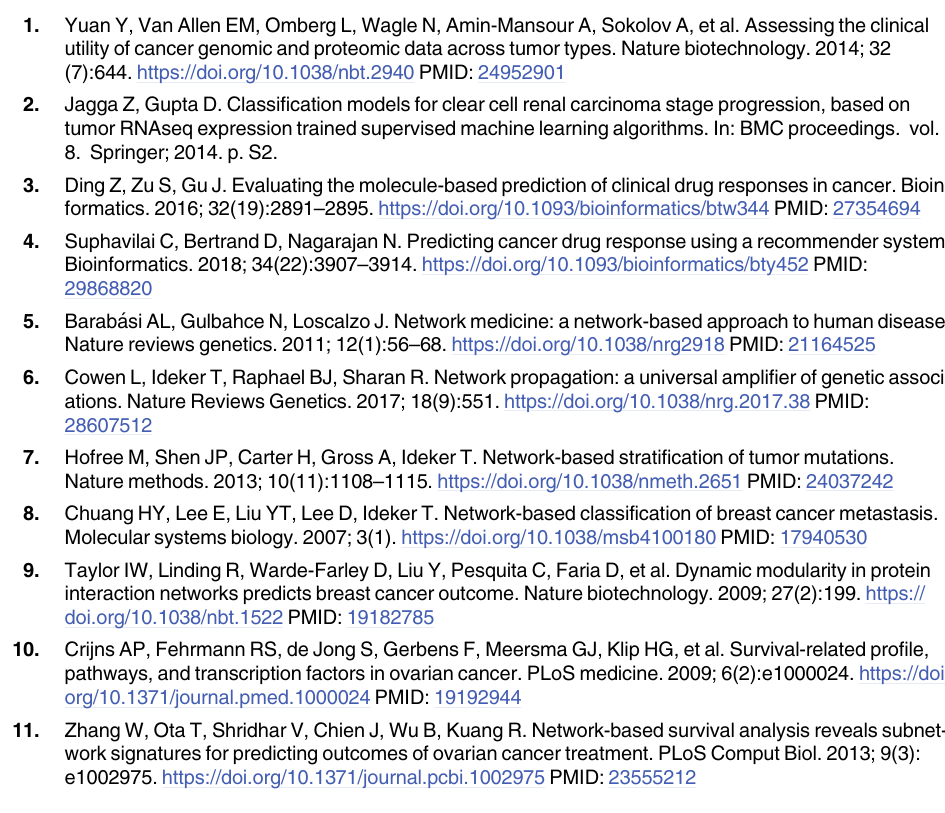
S1 Table. Feature rank differences in each cancer with PRER.